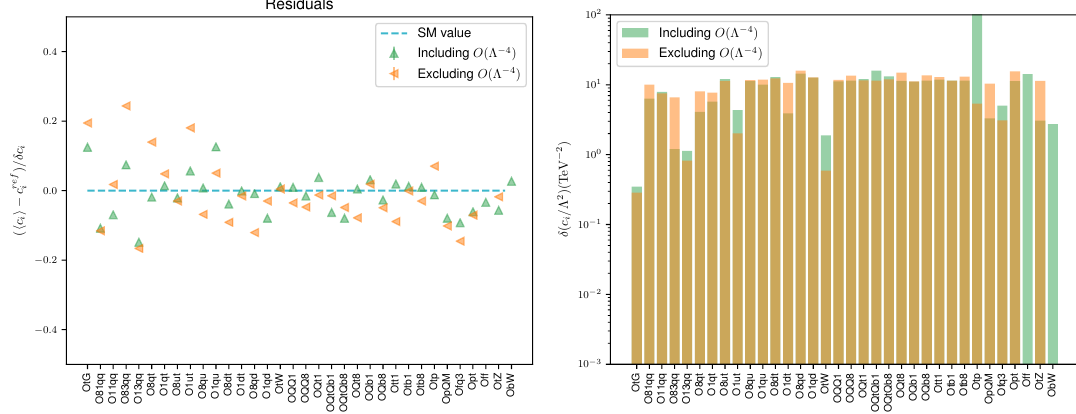
Figure 12 . Same as (cid:12)gure 6, now comparing the results of two L2 closure test (cid:12)ts with and without